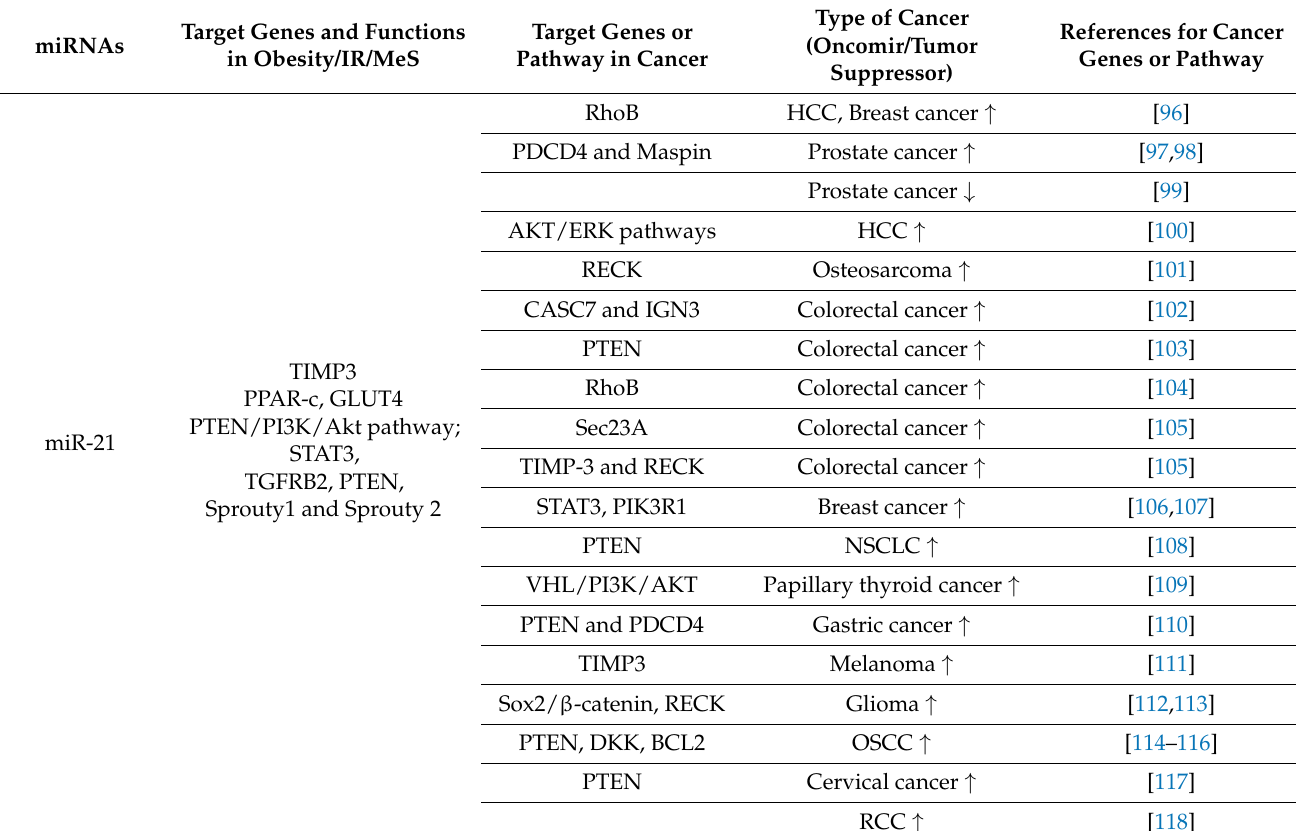
Table 1. Adiposity-related miRs with potential role in